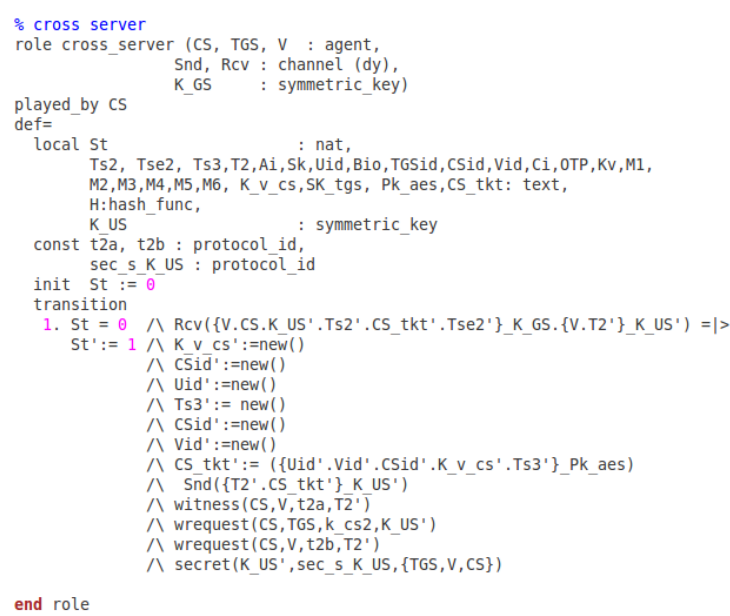
Figure 14. The CS’s role in HLPSL.